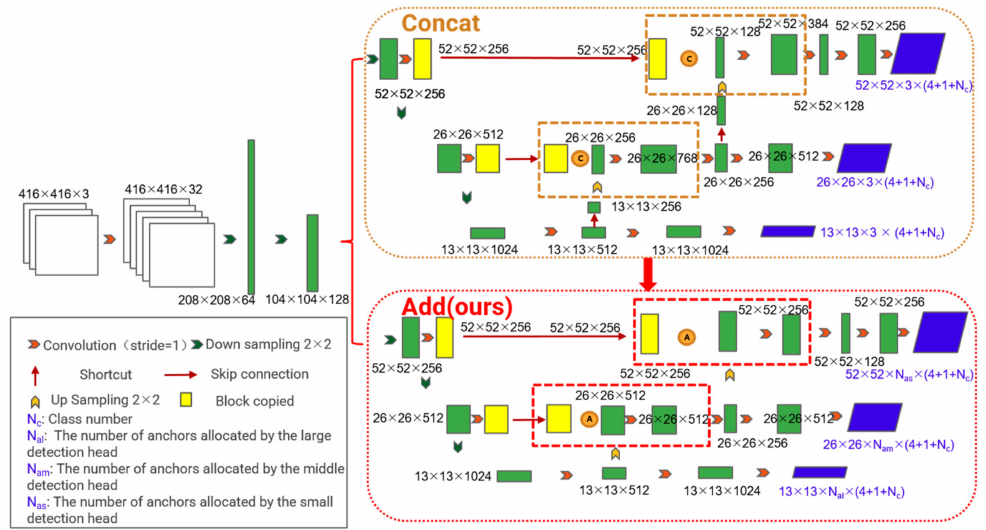
Figure 4. Addition fusion strategy for multi-scale imbalanced features based on